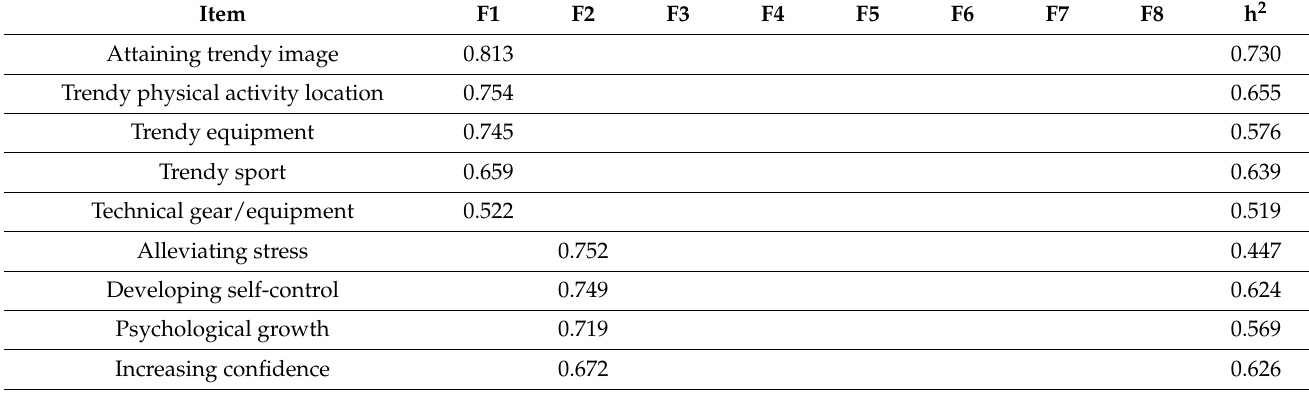
Table 2. The final solution of the exploratory factor analysis with eight meaning dimensions and 32 retained items with rotated factor loadings (loadings below 0.50 omitted) and extracted